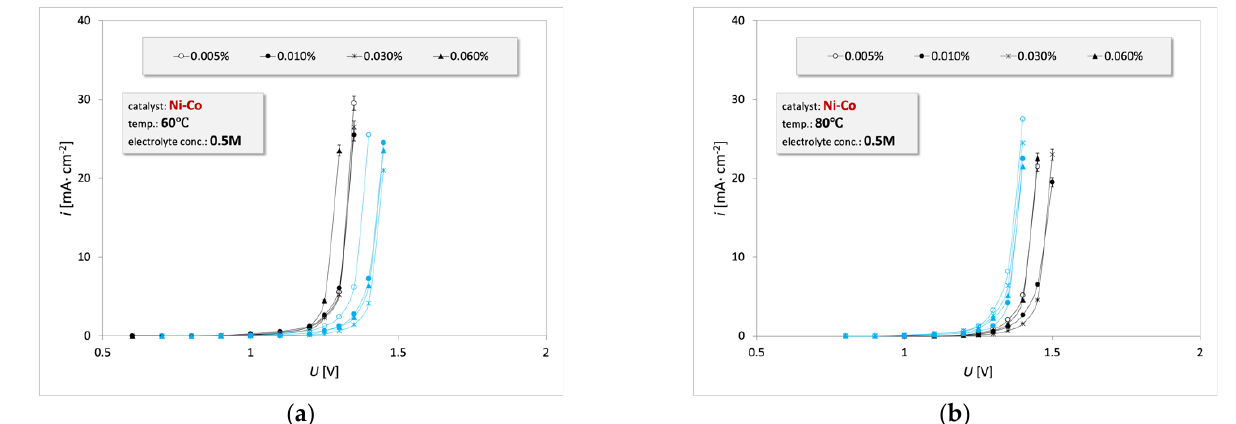
Figure 7. Electrooxidation curves of WEO emulsion (black lines) and detergent (blue lines) for various concentrations of detergent and emulsion on the Ni-Co catalyst for an electrolyte concentration of 0.5 M. Electrooxidation: ( a ) temperature: 60 °C; ( b ) temperature: 80 °C.